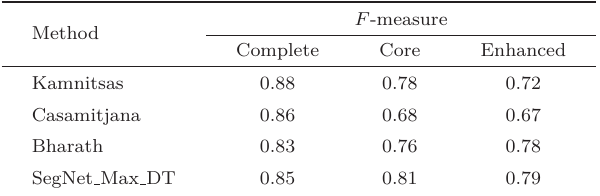
Table 2 Comparison of our method and other methods on the BraTS 2017 dataset F -measure Method Complete Core Enhanced